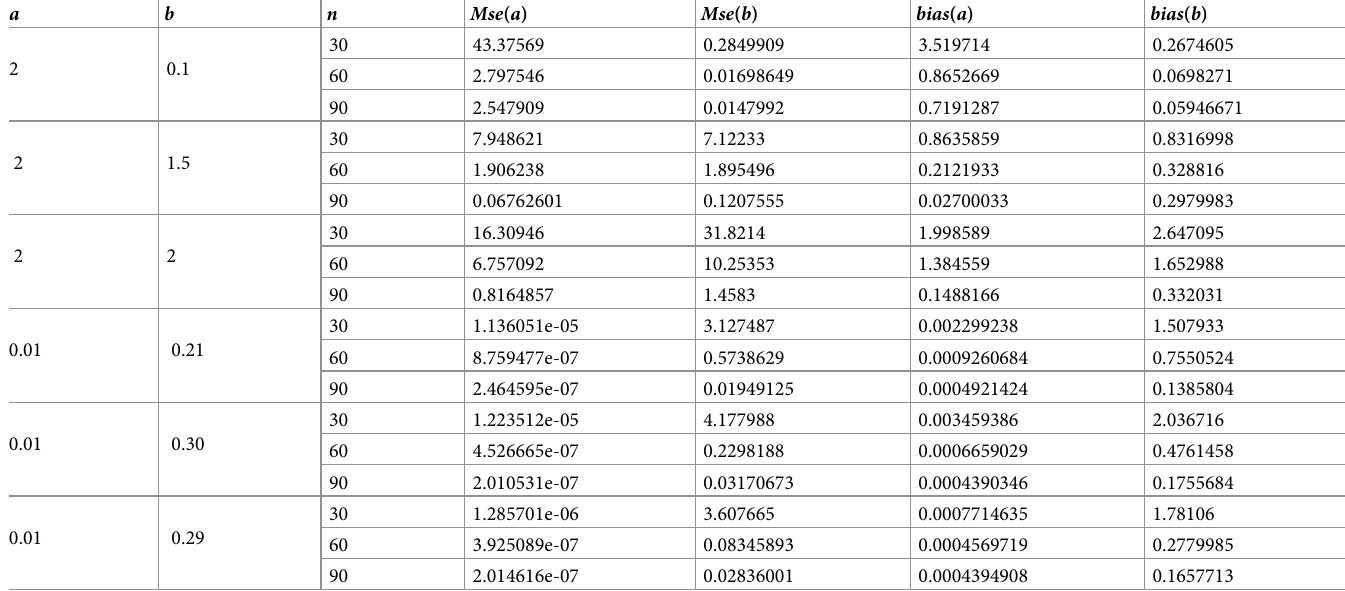
Table 5. Mean bias and MSE of LE ( a , b )distribution.